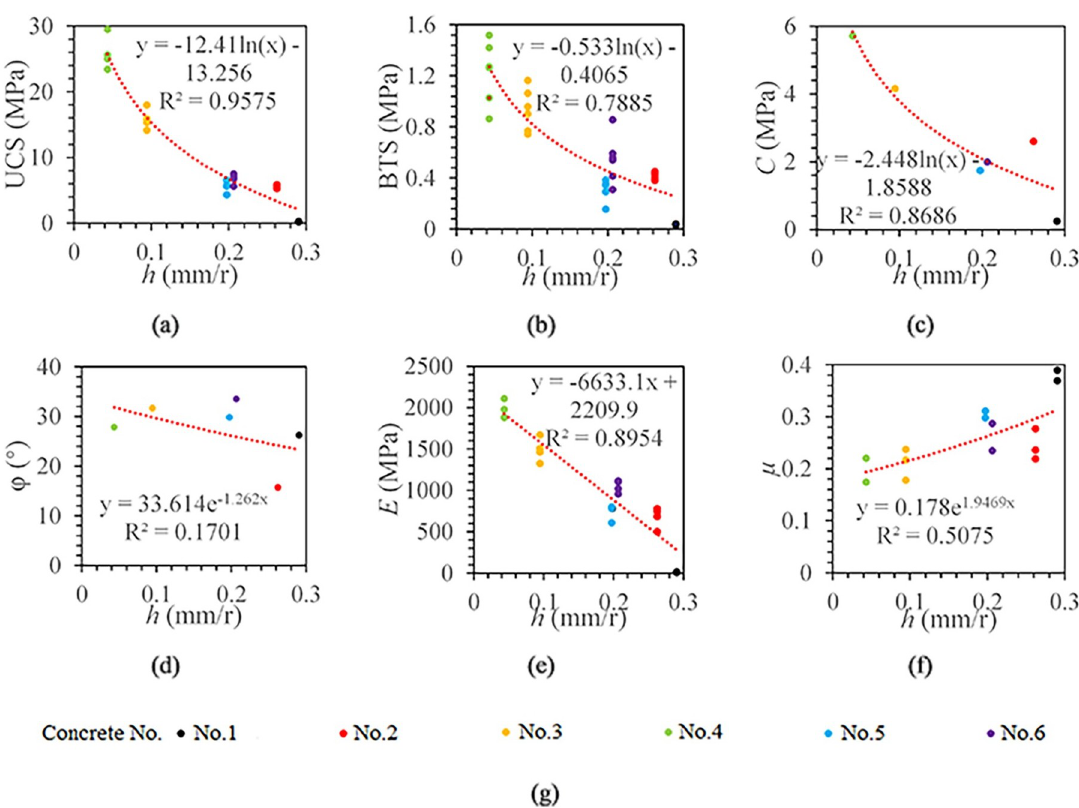
Fig 9. The relationship between penetration depth per revolution and concrete mechanical properties. (a) The relationship between h and UCS. (b) The relationship between h and BTS. (c) The relationship between h and C . (d) The relationship between h and φ . (e) The relationship between h and E . (f) The relationship between h and μ . (g) legend.